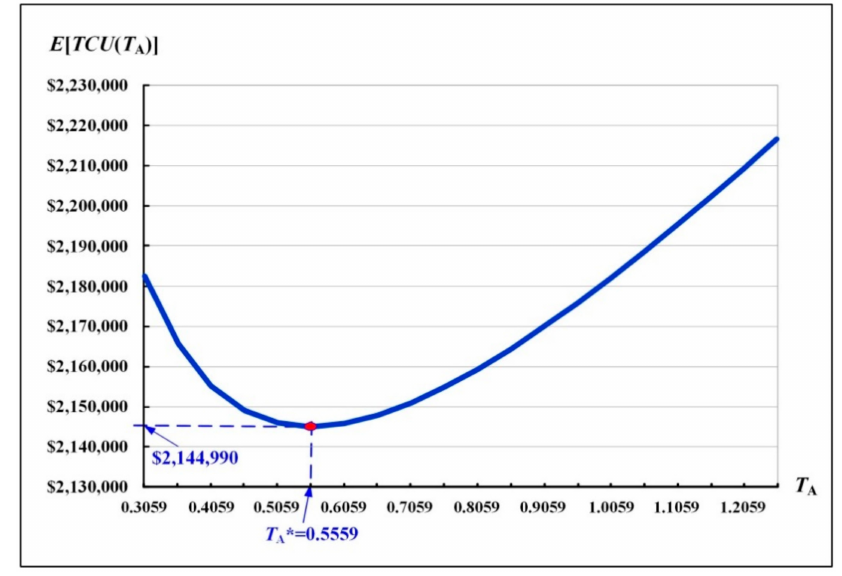
Figure 4. The analytical result on the convexity of E [ TCU ( T A